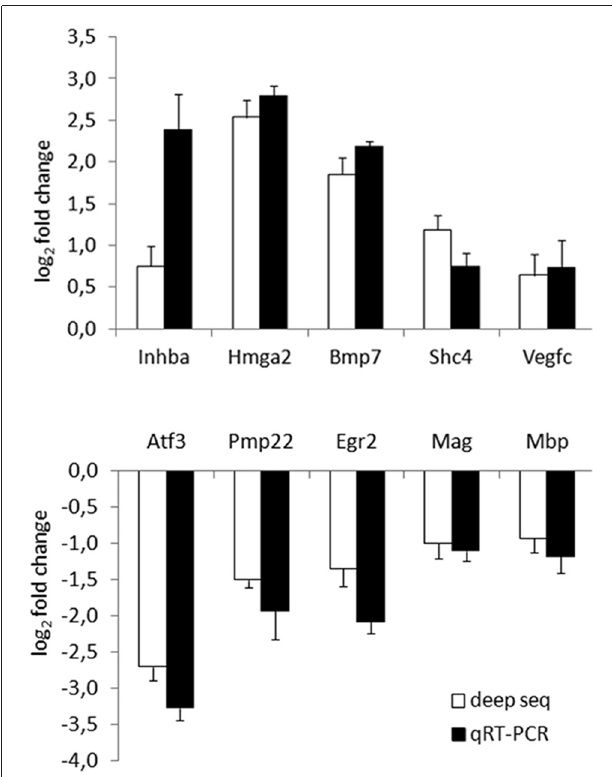
FIGURE 2 | Deep RNA sequencing validation through quantitative real time-PCR (qRT-PCR). Validation of 10 representative gene transcripts was performed by qRT-PCR, showing that the behaviour of five up- and five down-regulated genes was consistent in both techniques. log 2 fold change (corresponding to − ∆∆ CT for qRT-PCR) obtained comparing samples treated with Neuregulin1 (NRG1) with mock treated samples is shown, both for deep sequencing, both for qRT-PCR data.